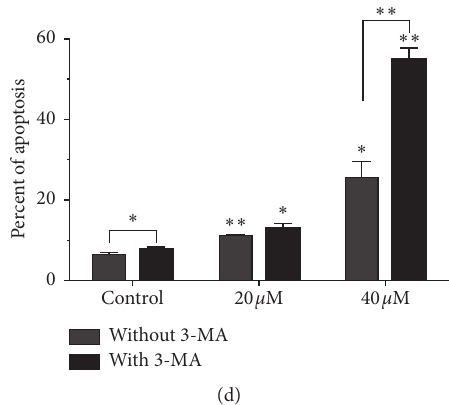
Figure 5: (a) Autophagy was detected in Eca-190 cells after exposure to complex 2 (0, 20, and 40 μ M) for 24h using MDC staining assay. (b) Relative quantitative data analysis of MDC fluorescence intensity for different treatment groups. (c) Apoptosis of Eca-109 cells was detected by flow cytometry after treated with complex 2 (0, 20, and 40 μ M) for 24 h with or without pretreatment of 3-MA. (d) Quantitative data analysis for the number of cells (% of total) in apoptosis for different treatment groups. Data were presented as mean ± SD ( n � 3), Student’s t -test, ∗ P < 0 . 05, ∗∗ P < 0 . 01.